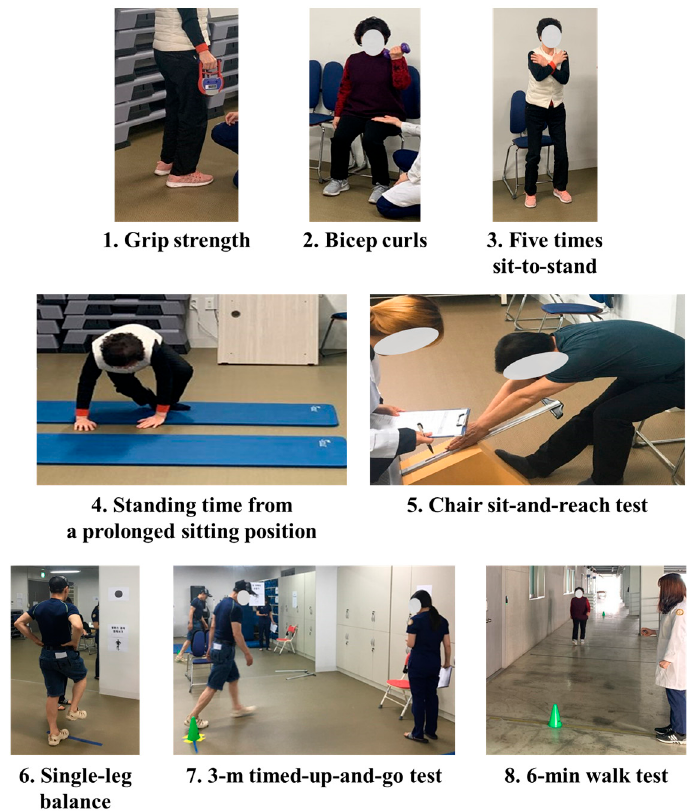
Figure 1. Physical fitness test.